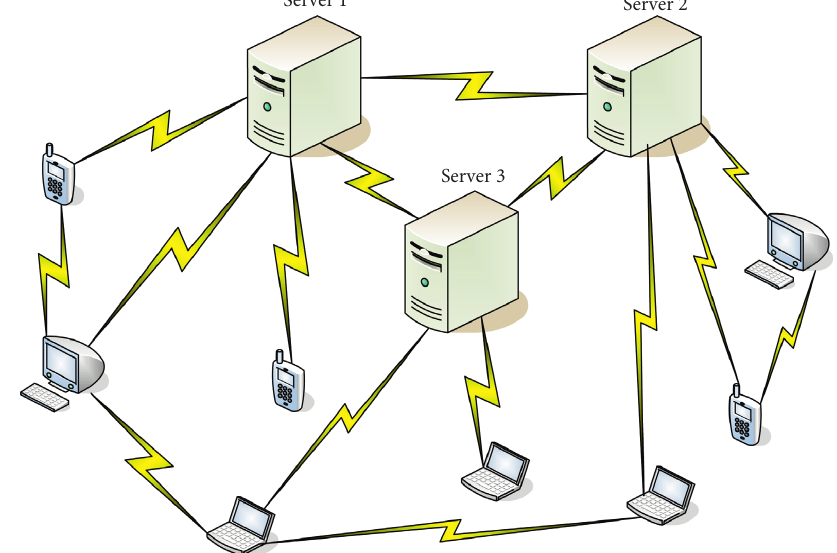
Figure 2: Schematic diagram of P2P networking architecture.